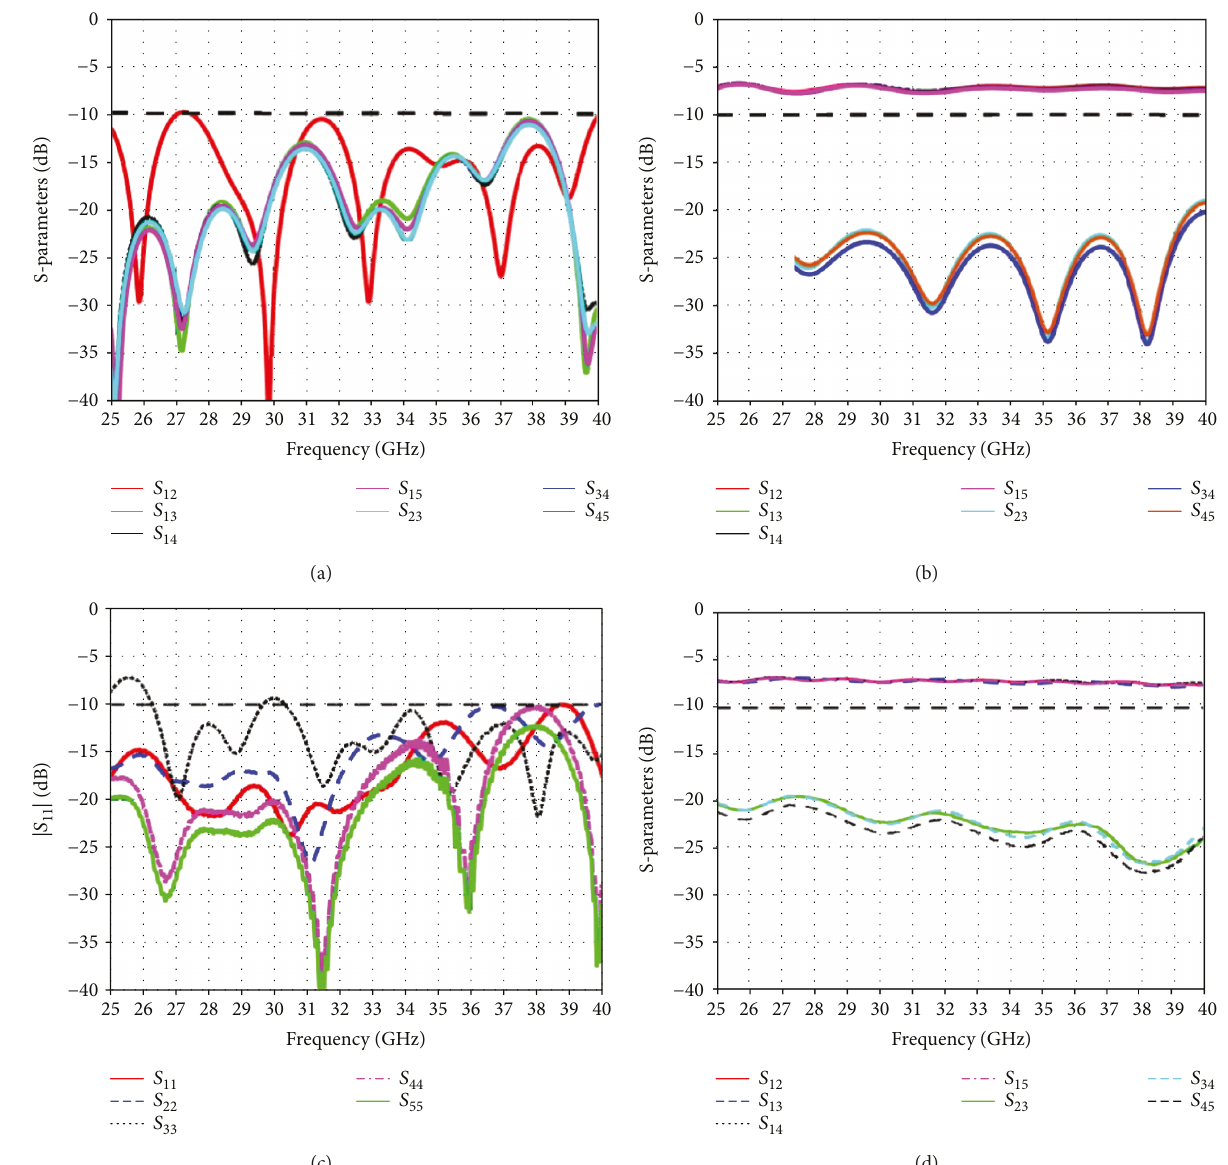
Figure 6: Simulated results of the 1 × 4 WPD (a) return loss ( S 1 × 4 WPD (c) re fl ection coe ffi cients and (d) insertion loss and isolation among